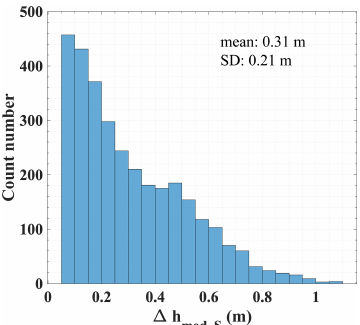
Figure 16. The distribution of (cid:49)h mod_S along the transect.